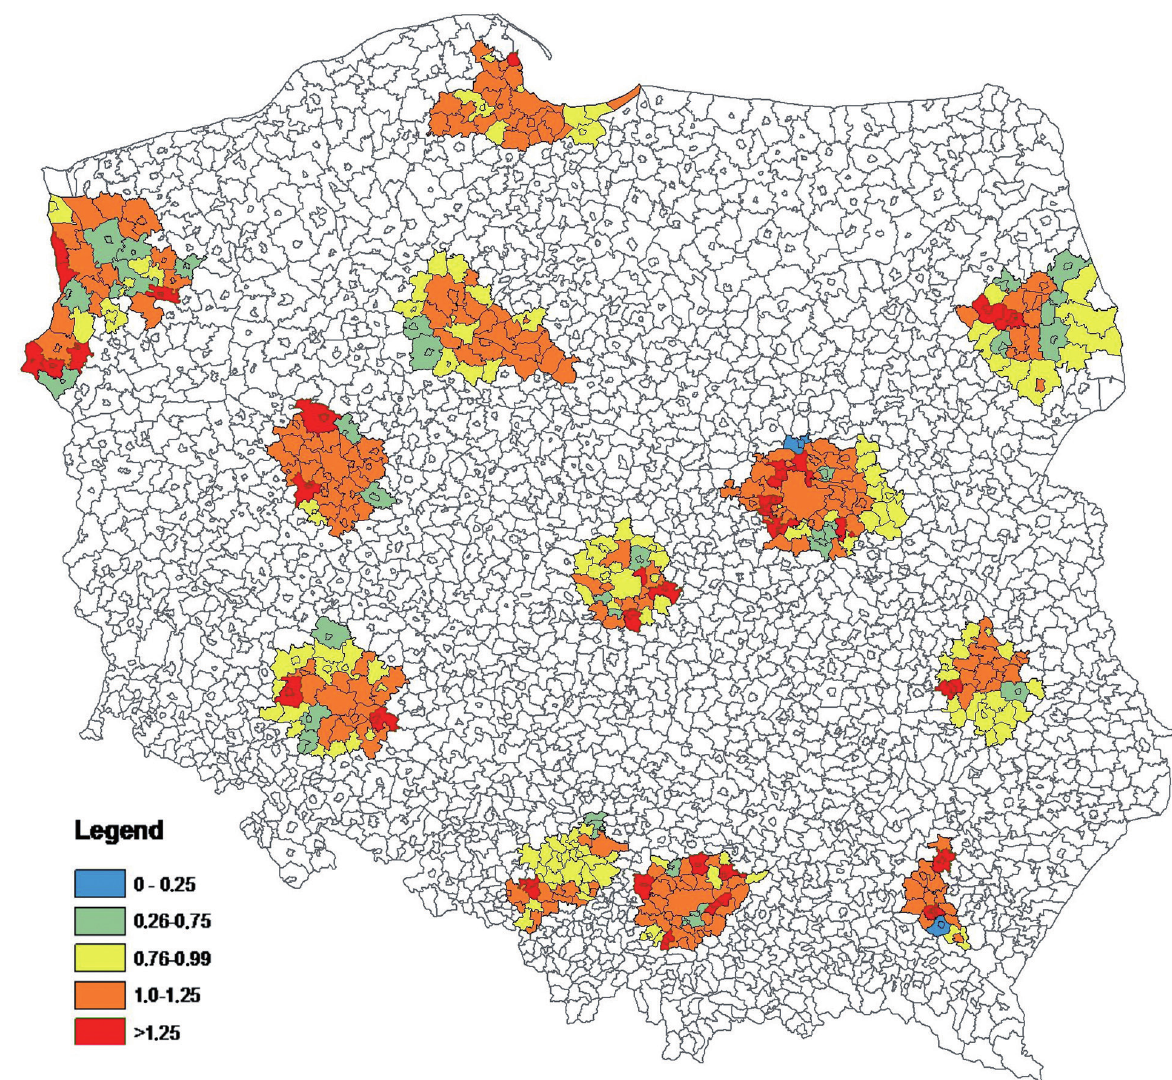
Fig. 1. Dynamics of spatial interactions in municipalities of the metropolitan areas of Poland (2000/1990, see explanation in